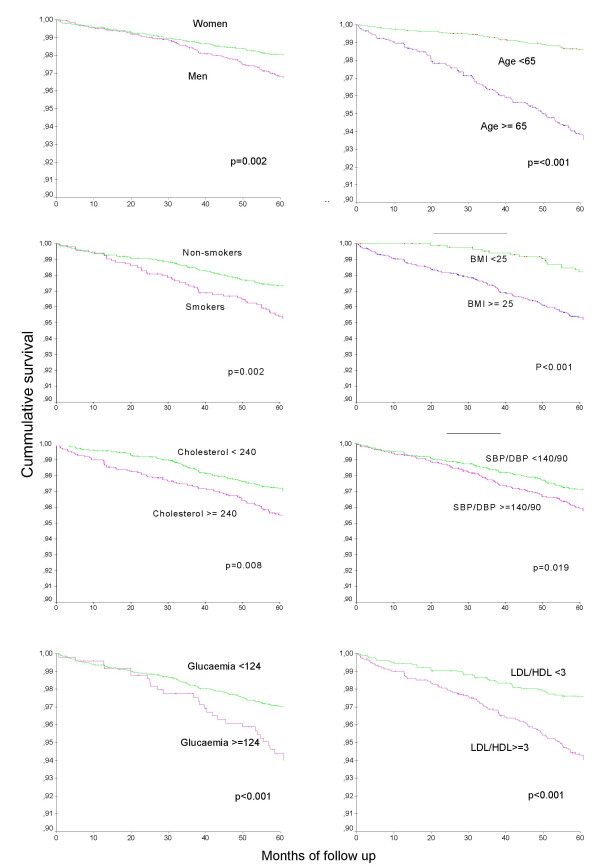
Ischaemic heart disease-free survival by category of vascular risk factors.